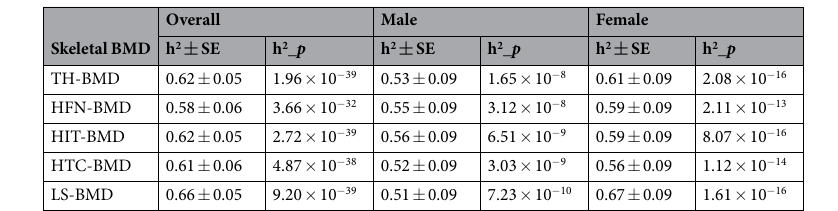
Table 2. Heritability of BMD in the OOA. TH-BMD: total hip BMD; HIT-BMD: hip intertrochanter BMD; HFN-BMD: hip femoral neck BMD; HTC-BMD: hip trochanter BMD; LS-BMD: lumbar spine BMD; SE: standard error of h 2 ; p: p value, Covariance including study, sex, age and family